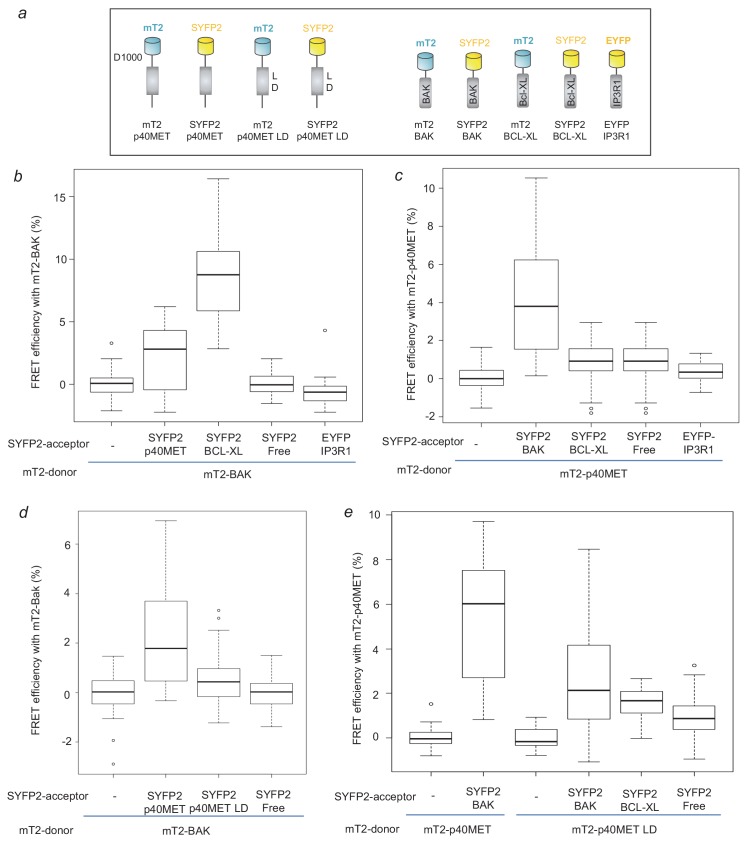
FRET measurement to analyze p40MET and BAK interaction.(a) Schematic representation of the mTurquoise2- or SYFP2-tagged proteins used for FRET analysis. (b) Cells were co-transfected with a vector expressing BAK-mT2 as FRET donor and with a vector expressing free SYFP2, BCL-XL-SYFP2, EYFP-IP3R1 or p40MET-SYFP2 as FRET acceptor. The fluorescence lifetime of BAK-mT2 was measured by Time-Correlated Single Photon Counting (TCSPC) and the FRET efficiency was calculated with respect to the donor-alone condition. At least 35 cells were counted for each condition. (c) Cells were co-transfected with a vector expressing p40MET-mT2 as FRET donor and a vector expressing free SYFP2, BAK-SYFP2, EYFP-IP3R1 or BCL-XL-SYFP2 as FRET acceptor. The fluorescence lifetime of p40MET-mT2 was measured by TCSPC and the FRET efficiency was calculated with respect to the donor-alone condition. At least 40 cells were counted for each condition. (d and e) Cells were co-transfected with a vector expressing BAK-mT2 as FRET donor and with a vector expressing free SYFP2, p40MET-SYFP2 mutated or not at the L and D residues of the putative BH3-like domain as FRET acceptor (d). Inversely, cells were co-transfected also with vectors expressing p40MET-mT2 mutated or not on the L and D residues as FRET donor and a vector expressing free SYFP2, BAK-SYFP2, or BCL-XL-SYFP2 as FRET acceptor (e). The fluorescence lifetime of p40MET-mT2 and BAK-mT2 were measured by TCSPC and the FRET efficiency was calculated with respect to the donor-alone condition. At least 30 cells were counted for each condition.Figure 2—source data 1.Source data of Figure 2b-e reporting FRET source data and diagram conception.